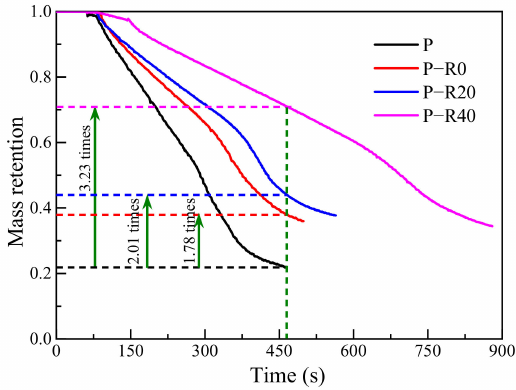
Figure 13. Mass retention rates of control and modified wood